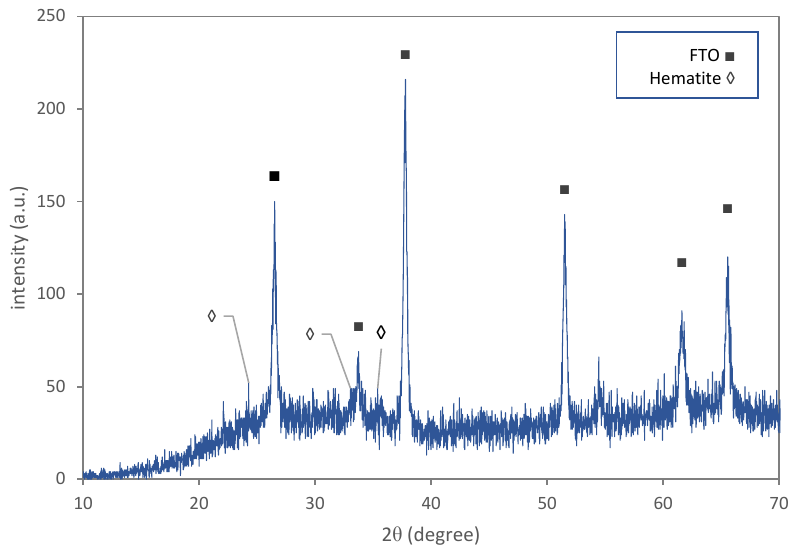
Figure 7. The XRD pattern of the thin film sample with FTO ‐ coated glass substrate after calcination.